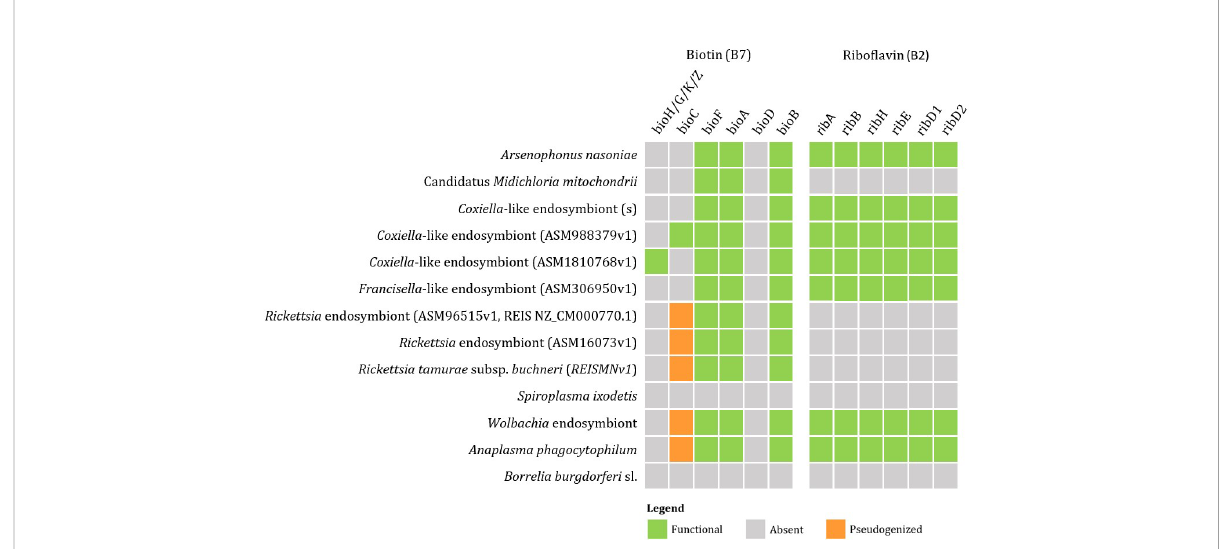
FIGURE 3 Schematic overview of endosymbiotic bacteria and pathogens transmitted by ticks with focus on gene clusters involved in vitamin B production (B7, B2). Color code: green – detected genes, grey – absent genes, orange – pseudogenized